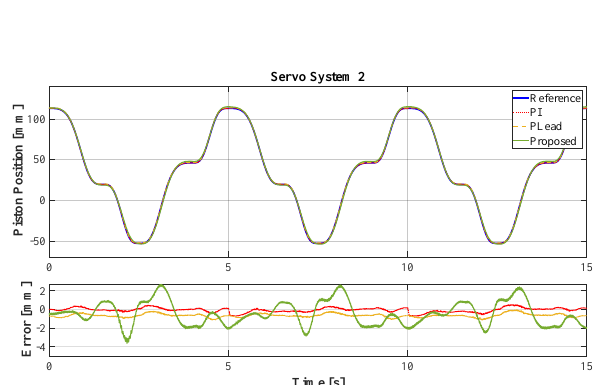
Figure 5: Tracking performance comparison of the pro- posed and reference controllers for servo sys- tem 1.